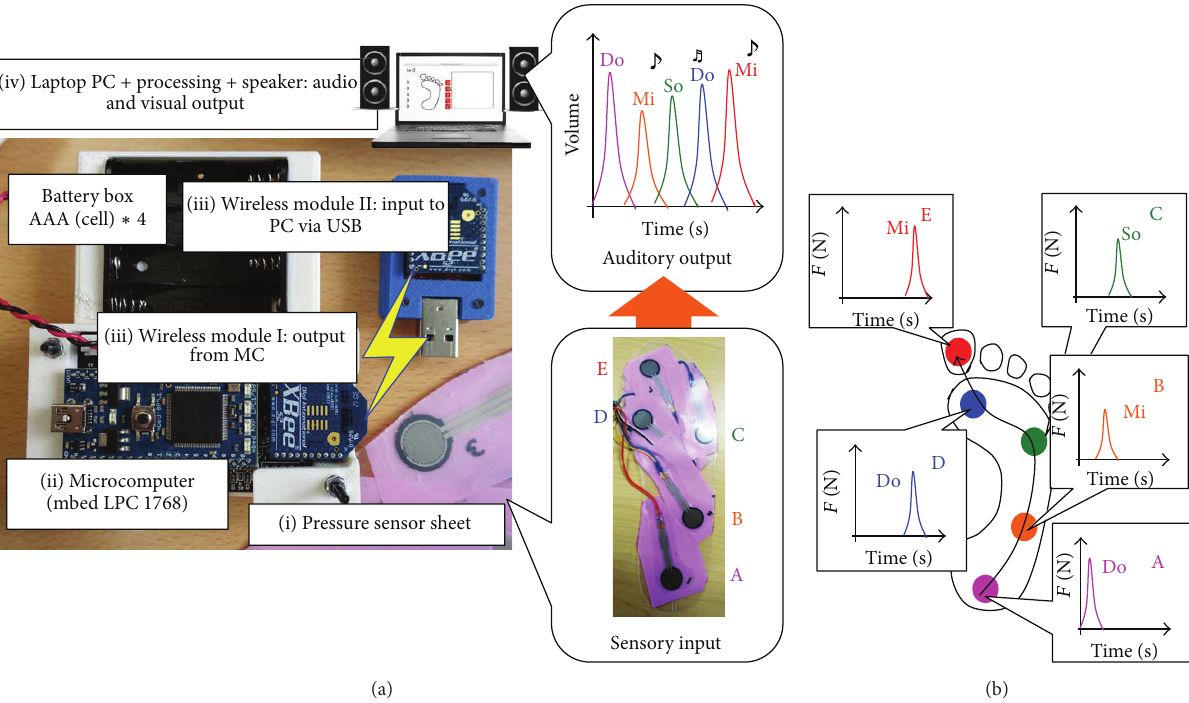
Figure 2: Overview of the proposed prosthesis transforming sensory modalities, called Auditory Foot [1]: (a) entire system of the sensor prosthesis, which consists of four components: (i) a pressure sensor sheet (input), (ii) a microcomputer (data processing), (iii) wireless communication devices (data transport from module I to module II), and (iv) a PC (output). (b) Protocol for transformation from pressure to auditory signals. The position of pressure sensors corresponds to “musical interval” (cf. Do, Mi, So, Do, and Mi) and the magnitude of pressure sensor values corresponds to “audio volumes.”